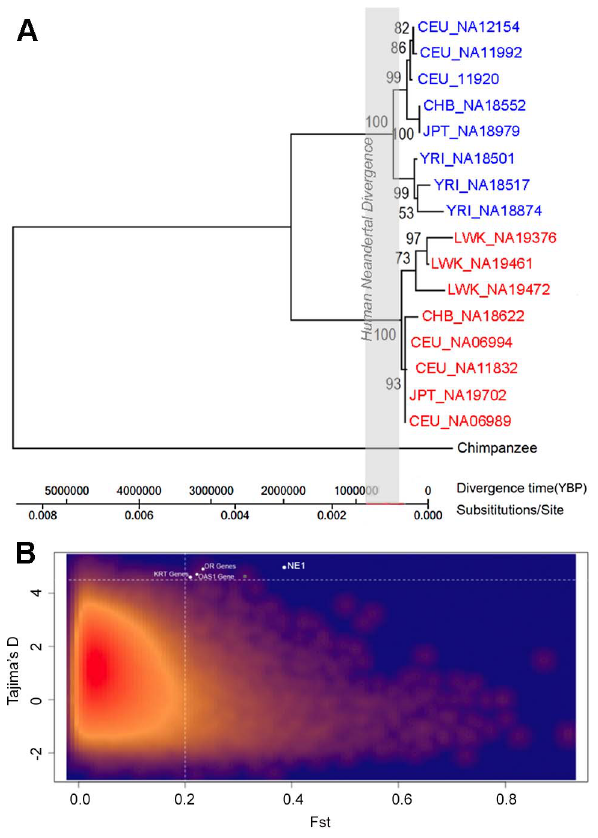
Figure 4. Selection acting on the NE1 locus. (A) Maximum likelihood tree based on select NE1 (red) and nonNE1 (blue) haplotypes, with the chimpanzee haplotype as an outgroup. The gray-box indicates the estimated interval for the Human-Neandertal divergence between 400,000–800,000 years ago [51]. Note that the coalescence at this locus is extremely long and very unlikely to have evolved under neutral conditions as modeled here. (B) Comparison of F ST and Tajima’s D values of 10 kb intervals across the human genome. The red to dark blue gradient indicates decreased density of observed events at a given location in the graph. The NE1 locus, and other loci with similar profiles, are highlighted in white.